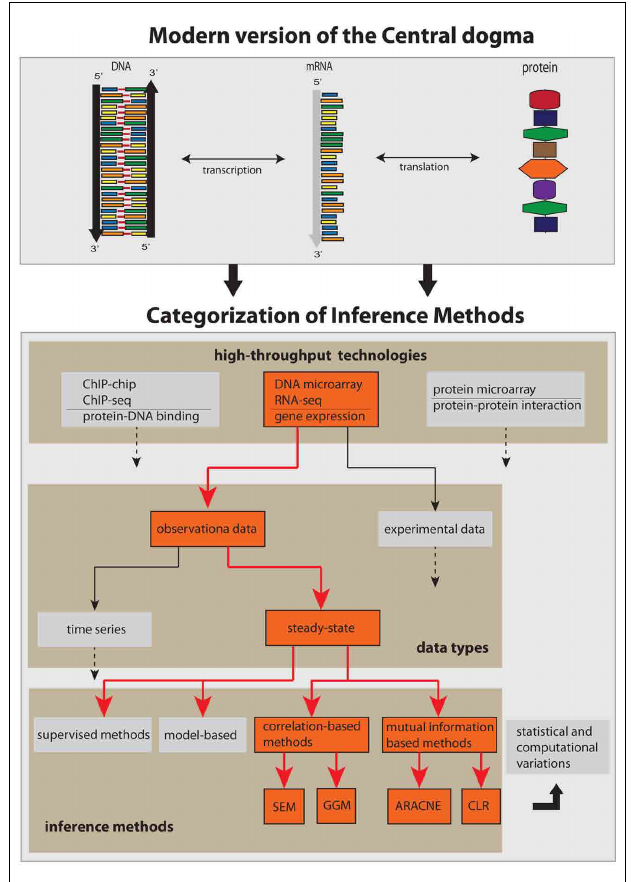
FIGURE 1 | Conceptual categorization of network inference methods and the biology, technology, and data types they depend on. The red arrows and boxes represent the focus of this review